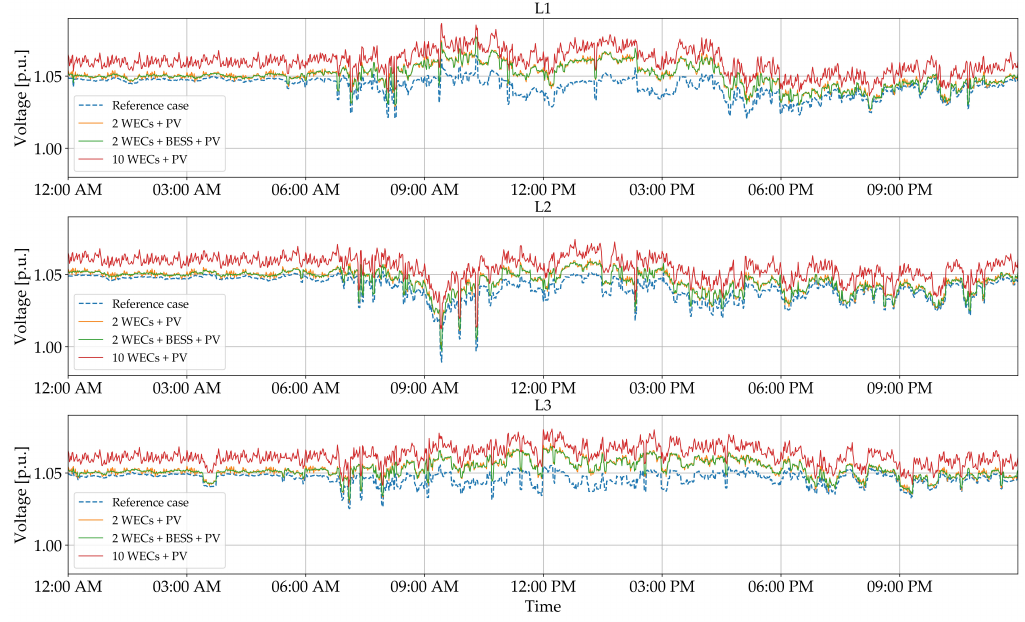
Figure 18. Voltage profiles at the WPF PCC bus for various scenarios in case study